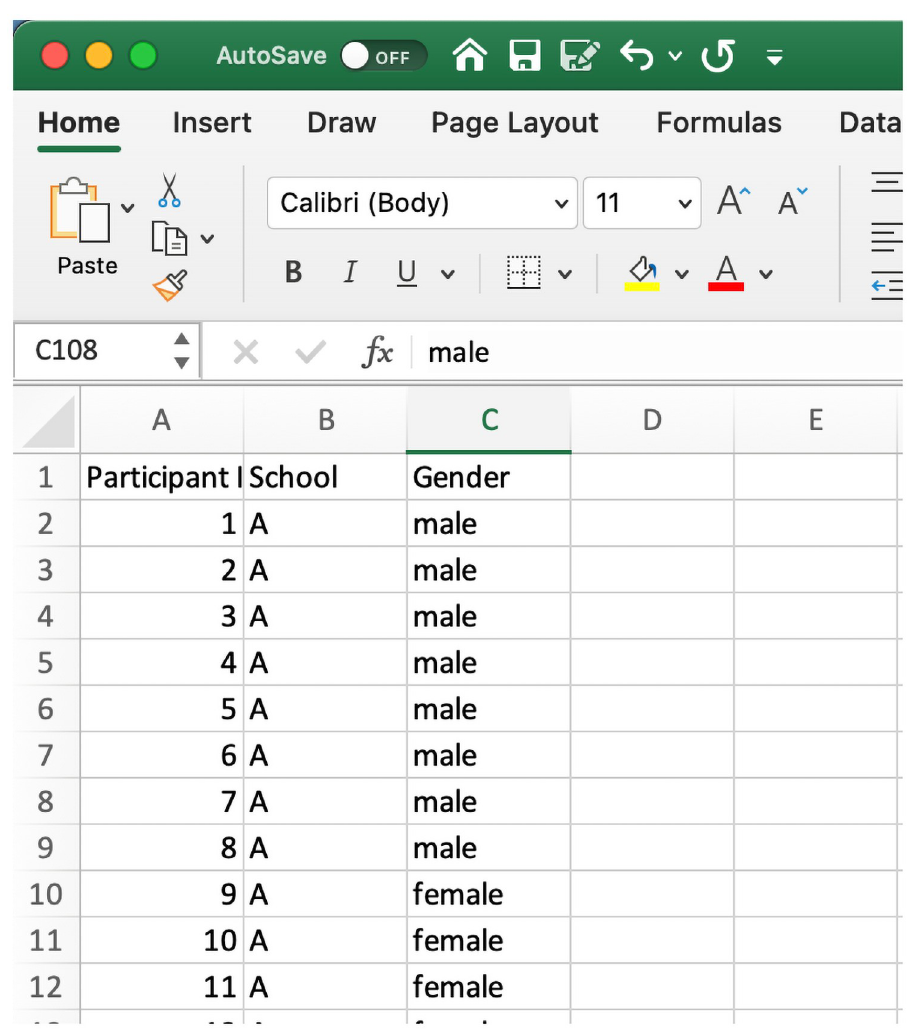
Fig 15. The Test_ANOVA_Group.xlsx